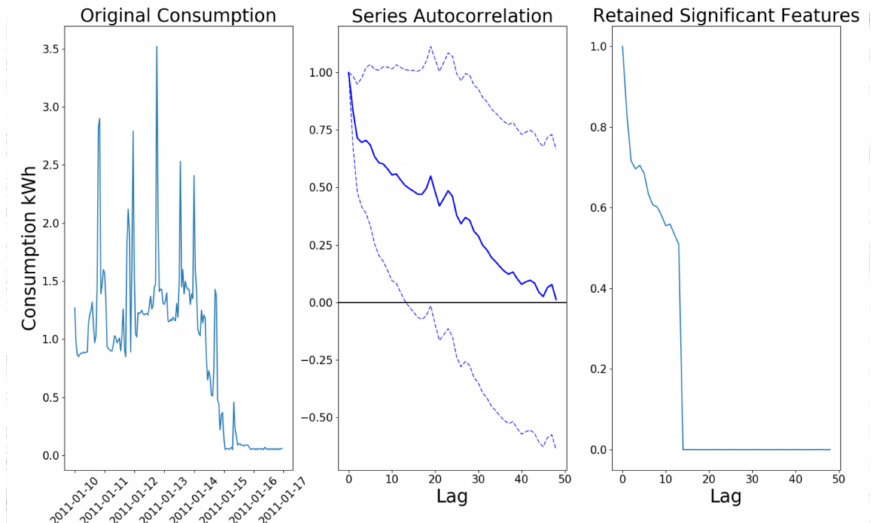
Figure 4. ( Left ) The original consumption profile, ( Middle ) the solid line is the autocorrelation coefficient, dashed lines are the 95% confidence intervals. ( Right ) Significant autocorrelation coefficients retained as meter features and applied as input to K-Means clustering. The significant lags only include the first 14 lags, indicating no recurrent pattern.